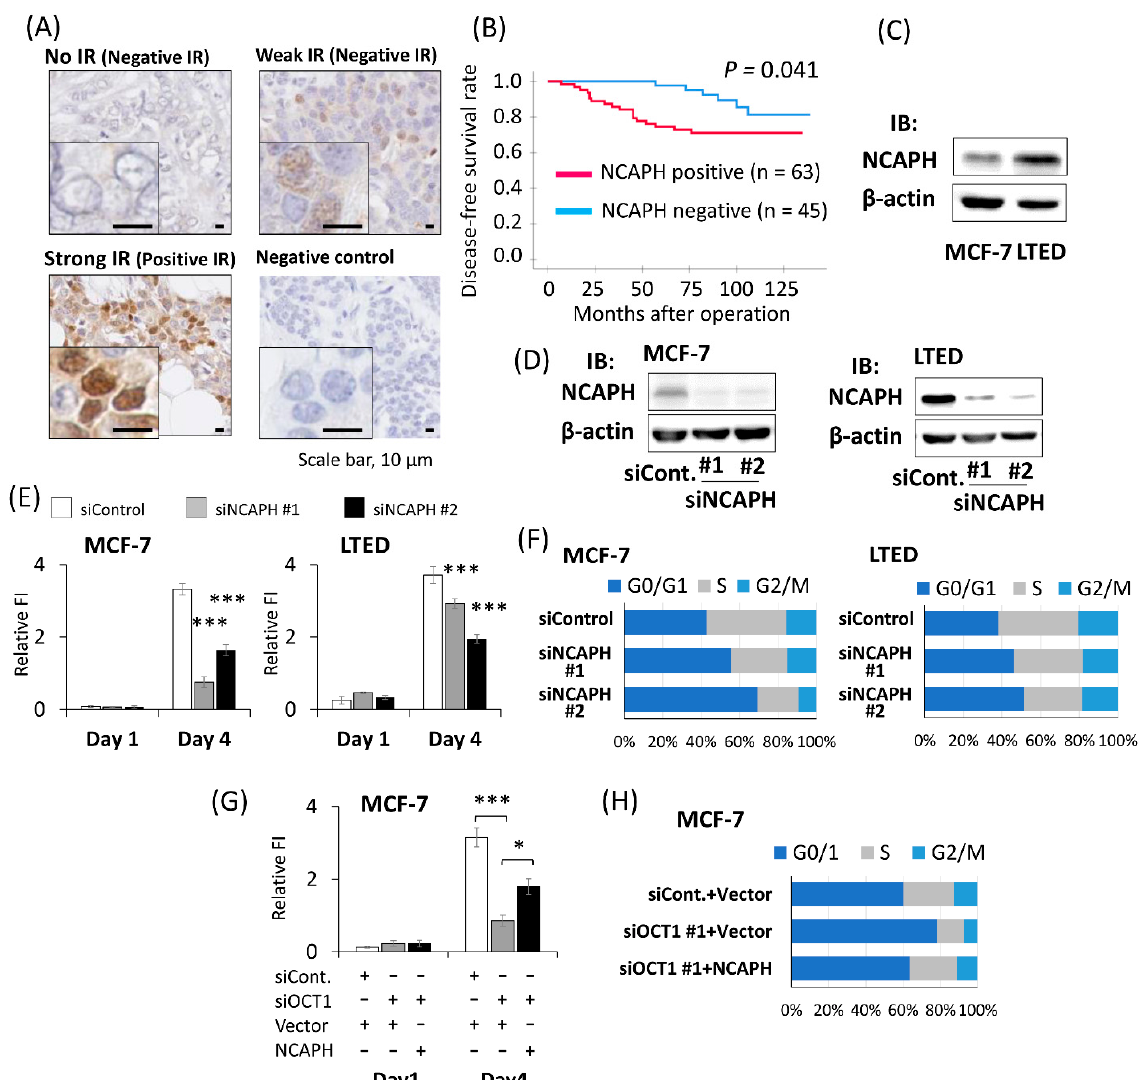
Figure 3. NCAPH was a poor prognostic factor in ER-positive breast cancer patients. ( A ) Representative micrographs of breast cancer tissues stained with NCAPH antibody. Strong immunoreactivity (IR) was defined as positive IR, whereas weak IR or no IR was defined as negative IR. One breast cancer tissue was applied with non-specific rabbit IgG antibody as a negative control. The scale bars represent 10 μ m. ( B ) Disease-free survival of breast cancer patients with positive or negative NCAPH IR is shown by the Kaplan–Meier method. p -value was determined by the log-rank test. The red line represents cases with positive OCT1 IR ( n = 63), and the blue line represents negative NCAPH IR ( n = 45). ( C ) Western blot analysis for NCAPH expression in MCF-7 cells and LTED cells. β -actin protein was blotted as a loading control. IB, immunoblot. ( D ) Western blot analysis for NCAPH expression in MCF-7 cells and LTED cells treated with two kinds of siRNAs for NCAPH (siNCAPH #1 or #2) or siControl (siCont.). β -actin protein was blotted as a loading control. ( E ) DNA